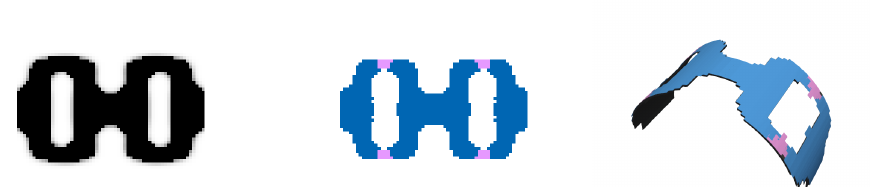
Figure 3. Structure layout ρ s ( left ), electrode profile ρ p ( centre ) and 3D design ( right ) for the second